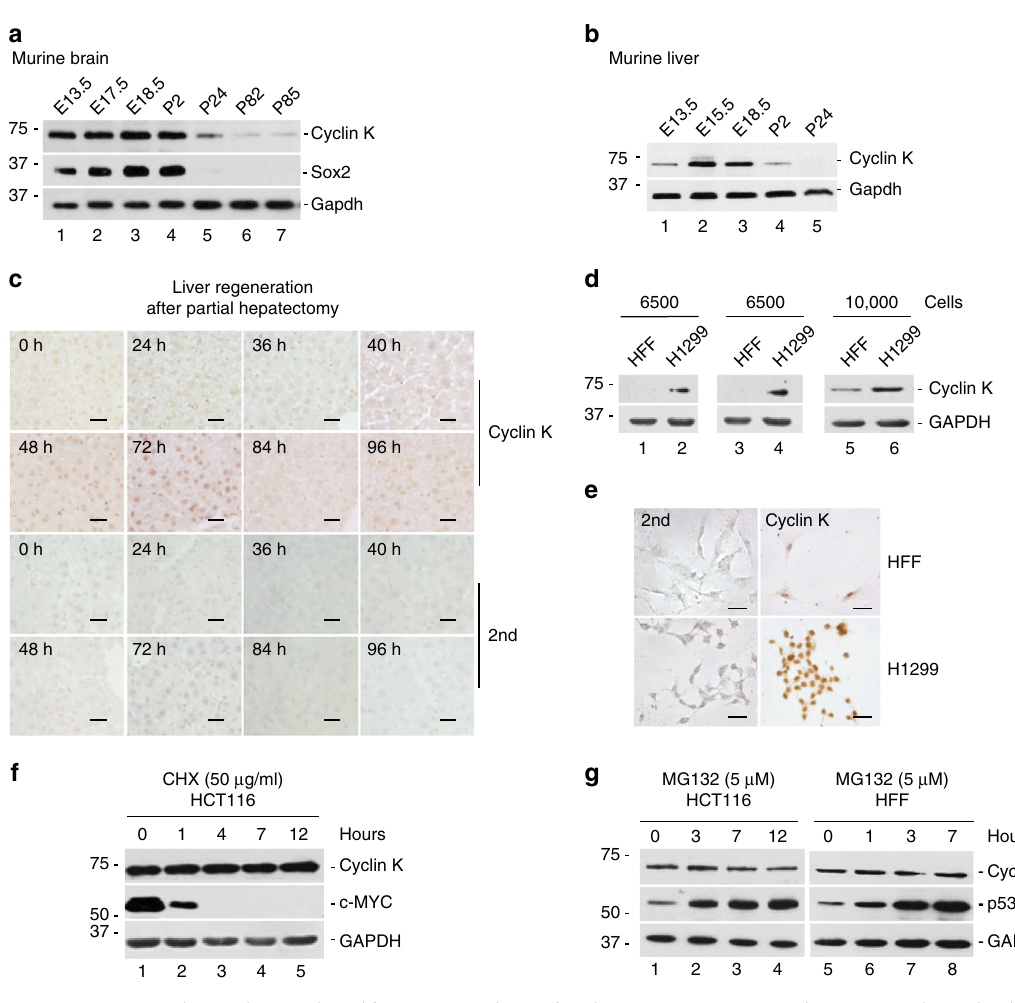
Fig. 1 Cyclin K expression positively correlates with proliferation. a Analyses of cyclin K protein expression during murine brain development by immunoblotting. Cyclin K protein expression in embryonic (E) and postnatal (P) murine brains correlated with that of Sox2, a marker of neural progenitor cell proliferation. b Analyses of cyclin K protein expression by immunoblotting during murine liver development. c Cyclin K expression detected by immunochemistry during the process of murine liver regeneration in vivo. 2nd, immunochemistry using secondary antibodies alone. 0 h denotes samples collected immediately after partial hepatectomy. Scale bar, 40 μ m. d Comparison of cyclin K by immunoblotting in normal and H1299 cancer cells using equal cell numbers as loading control. HFF, neonatal human foreskin fi broblast. e Cyclin K expression detected by immunochemistry in normal and H1299 cancer cells. HFF, neonatal human foreskin fi broblast. Scale bar, 40 μ m. f Time course analyses of cyclin K expression by immunoblotting in HCT116 cells treated with protein synthesis inhibitor cycloheximide (CHX, 50 μ g/ml). g Time course analyses of cyclin K expression by immunoblotting in cells treated with proteasome inhibitor MG132 (5 μ M) in human normal and HCT116 cancer cells. HFF, neonatal human foreskin fi broblast. Experiments were repeated for three times ( a – c ), and more than three times when cell lines were used ( d – g ). Representative results are